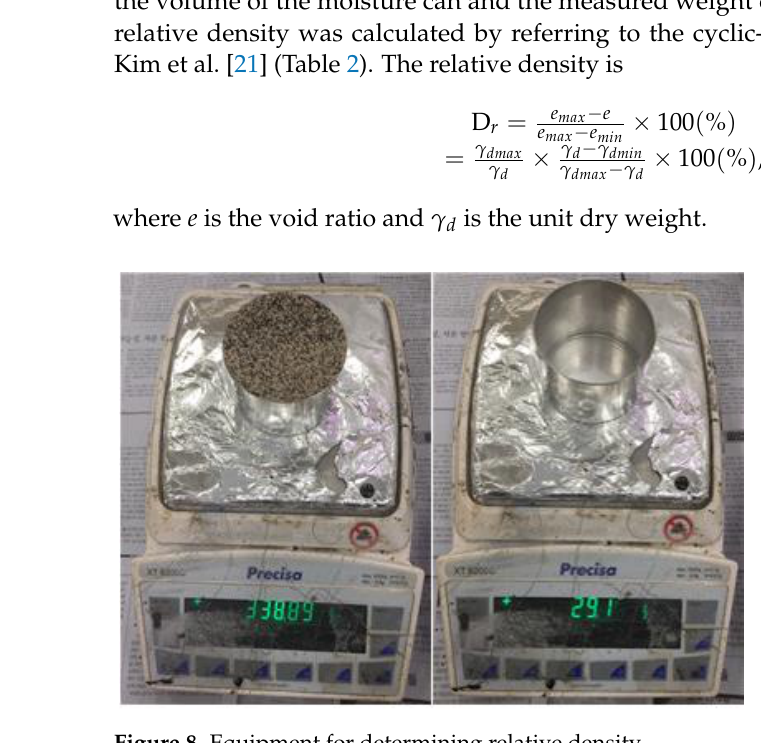
Figure 8. Equipment for determining relative density. Table 2. Properties of sandy soil with various relative densities [21].